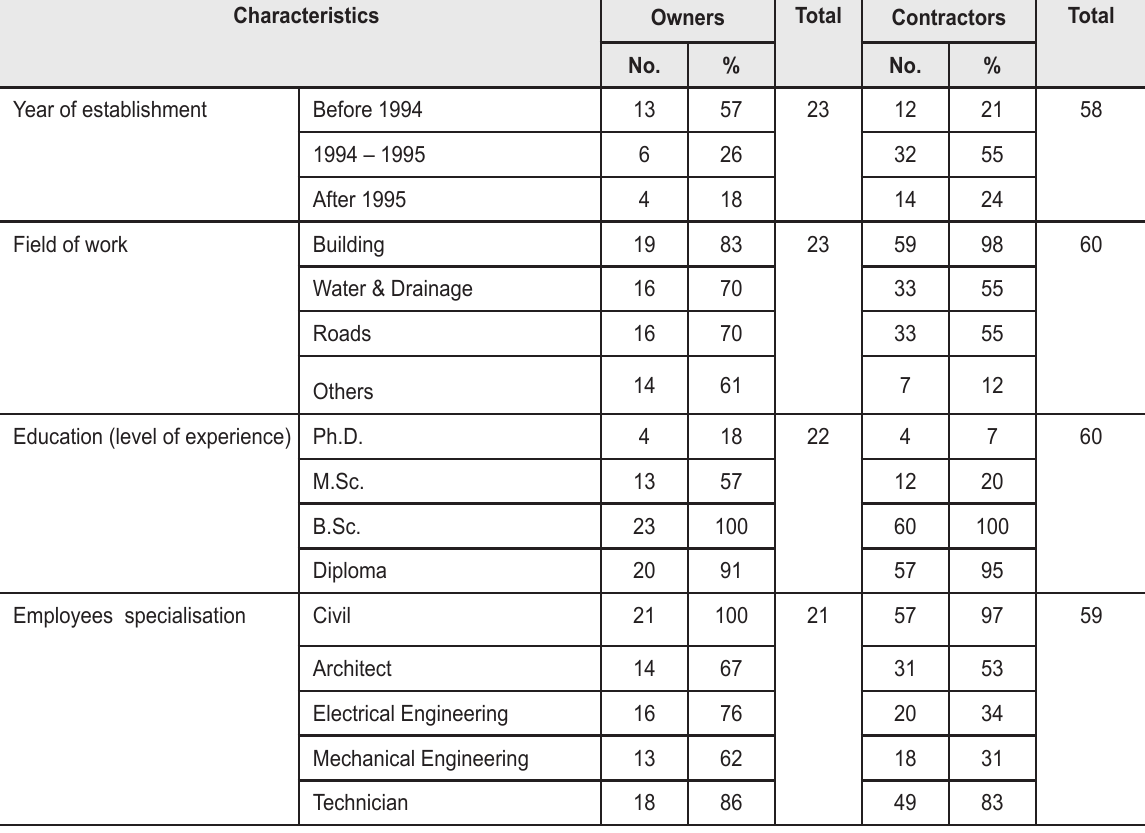
Table 1: Summary of the main characteristics of the study